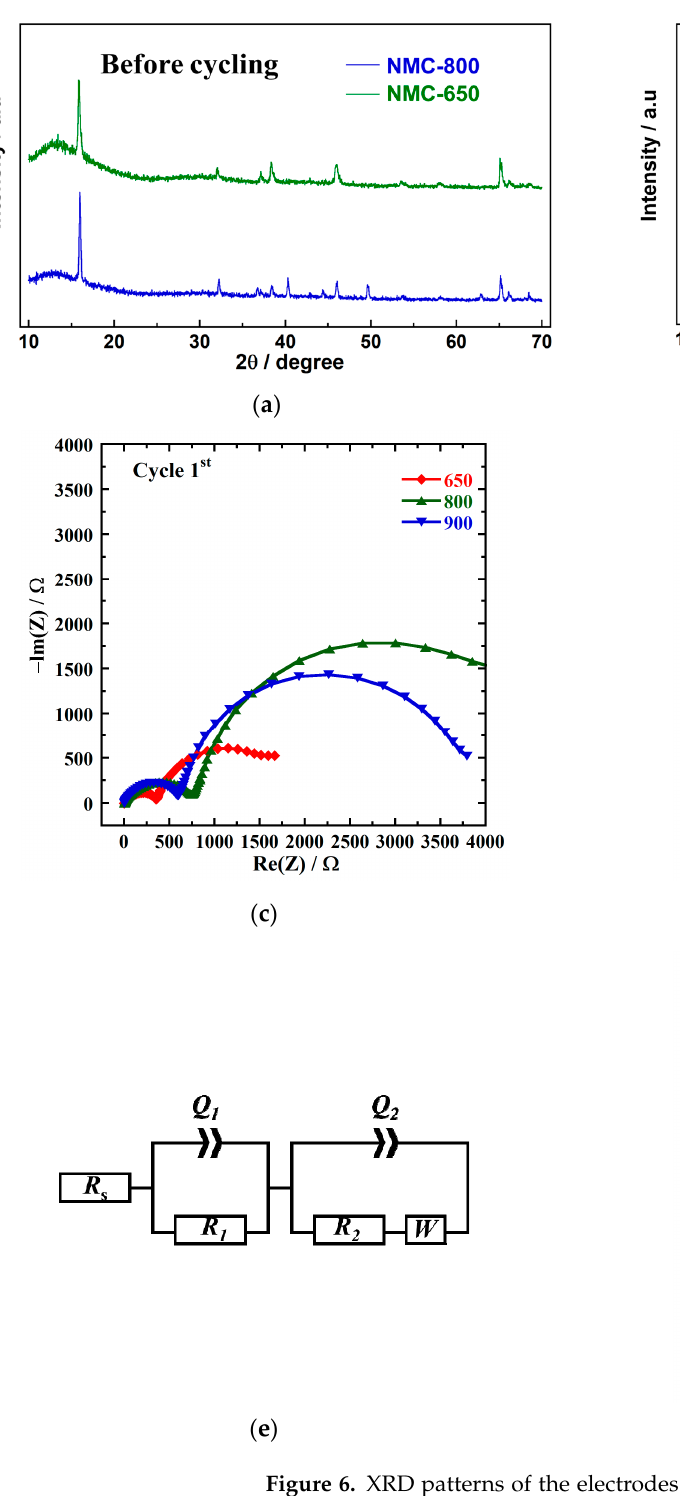
peaks’ intensity increased but the CV pro fi les were almost unchanged, indicating high redox reversibility and coinciding to the prominent rate capability of the electrodes. The plot of peak current intensity versus square root of scan rate was used to deter- mine whether the redox reaction was di ff usion controlled [41]. The peak intensity of the oxidation peak and reduction peak located at around 4 V were plo tt ed versus the square root of the scan rate and illustrated in Figure 7d, for instance. The fi tt ed lines indicated that the linear relationship was satis fi ed, and so, the forward and reverse reactions were di ff usion controlled. The feature was also recognized using the fi tt ing way with other peaks in the CV pro fi les. Therefore, the di ff usion coe ffi cients can be calculated according to the Randles–Sevcik equation [41]: